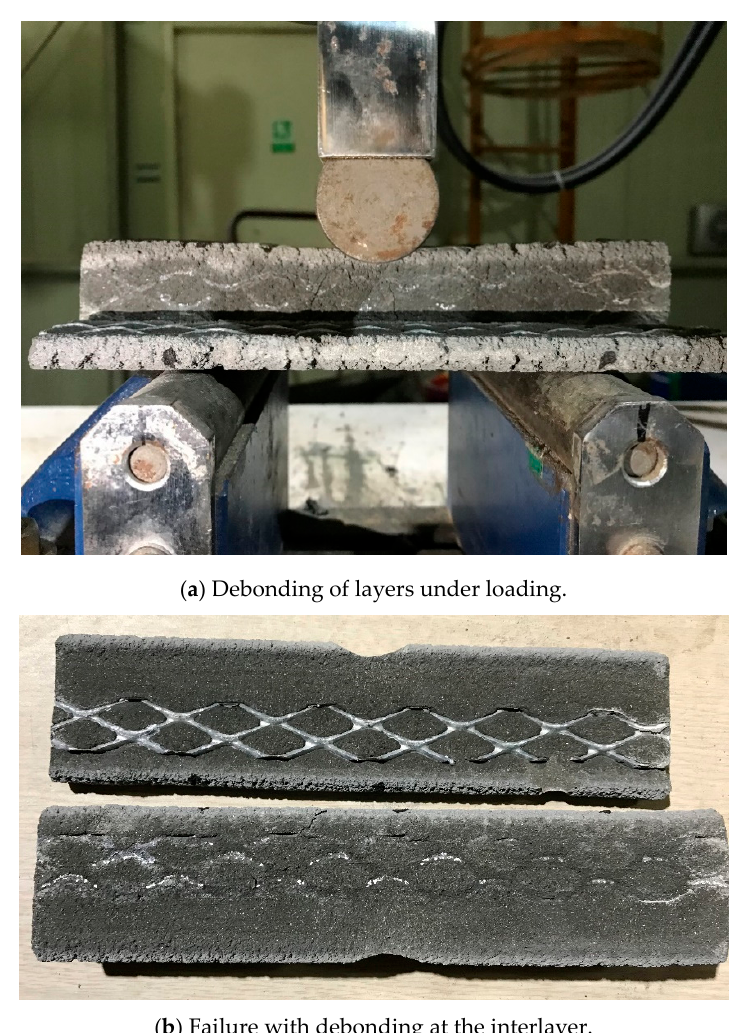
Figure 13. Flexural tensile failure of printed specimens in loading direction II.